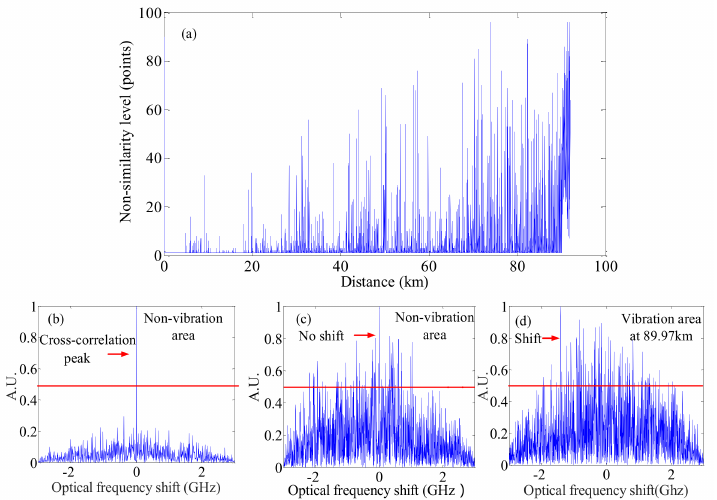
Figure 21. ( a ) Measured distributed “non-similarity levels” as a function of FUT length. Vibration events cannot be located by significant variations of “non-similarity level”. ( b ) Cross-correlation between two local RBS in the non-vibration area at a short sensing range, ( c ) in the non-vibration area at a long sensing range, ( d ) in the vibration area (89.97 km). The red line is half of the cross-correlation peak and the cross-correlation peak is indicated by the red arrow (reprinted from Ding et al. [55] with permission of IEEE; copyright (2017)).